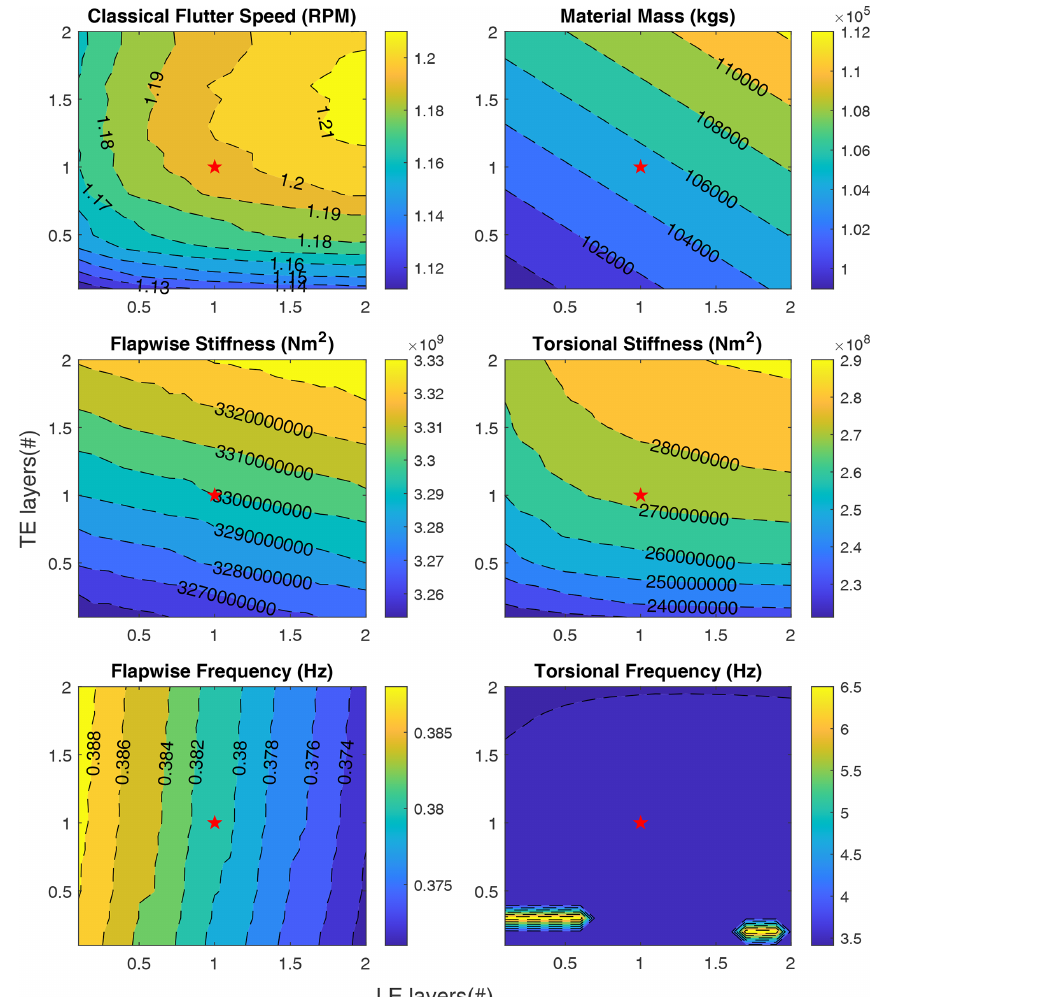
Figure 12. LE and TE sweep for the two-bladed SUMR13 blade. The red star in the plots indicates the baseline blade design